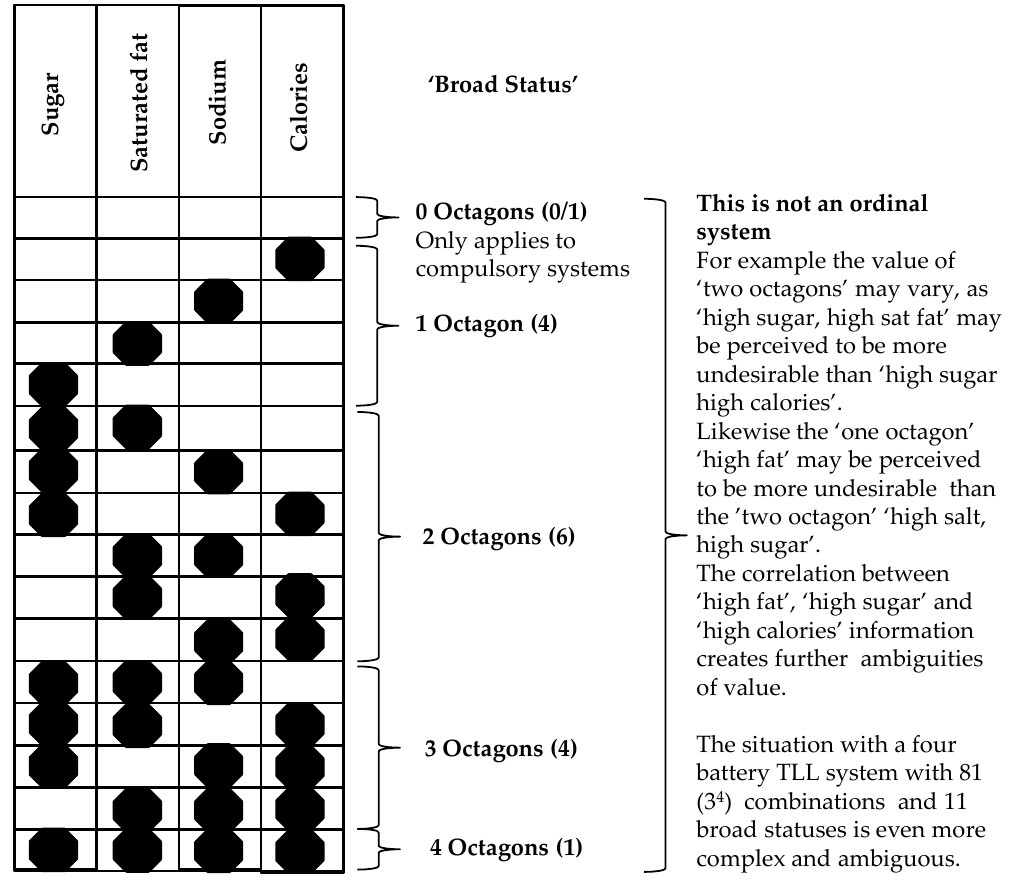
Figure 2. The geometric increase in complexity when multiple labels are used. The Chilean octagon system based upon four binary octagonal labels.